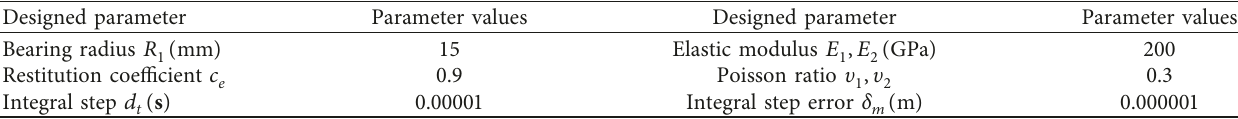
Table 2: Clearance joints and integration